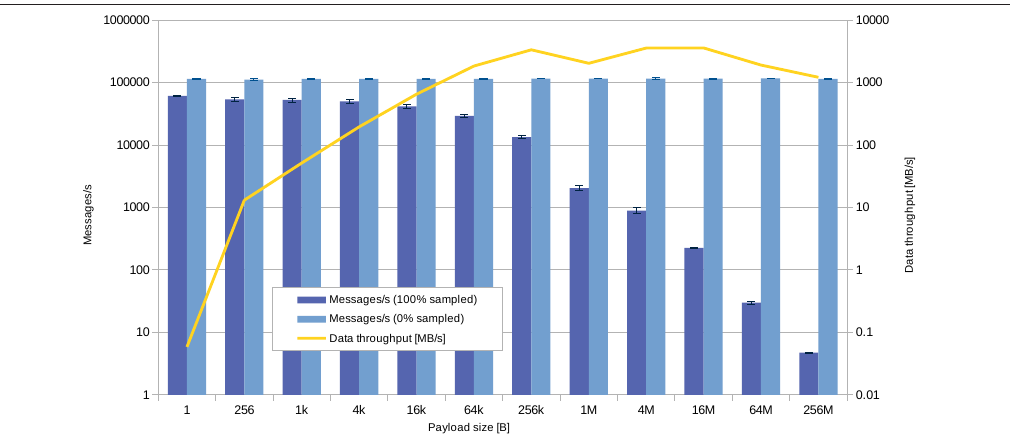
Figure 3. The performance of Dispatcher as a function of the message payload size. Table 1. The performance of publishing 2D histograms by QC Tasks. Object size (in RAM) 1 kB 10 kB 100 kB 1 MB 10 MB Number of objects [ / s] > 100000 > 30000 > 8100 > 1000 >